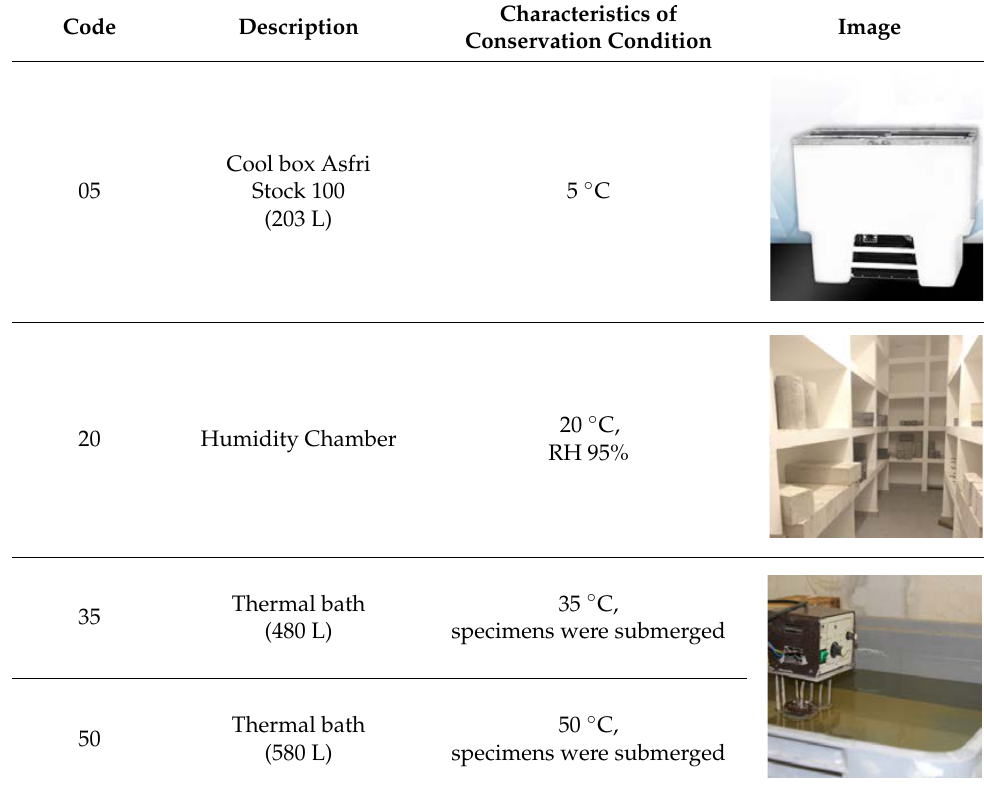
Table 3. The conservation conditions.